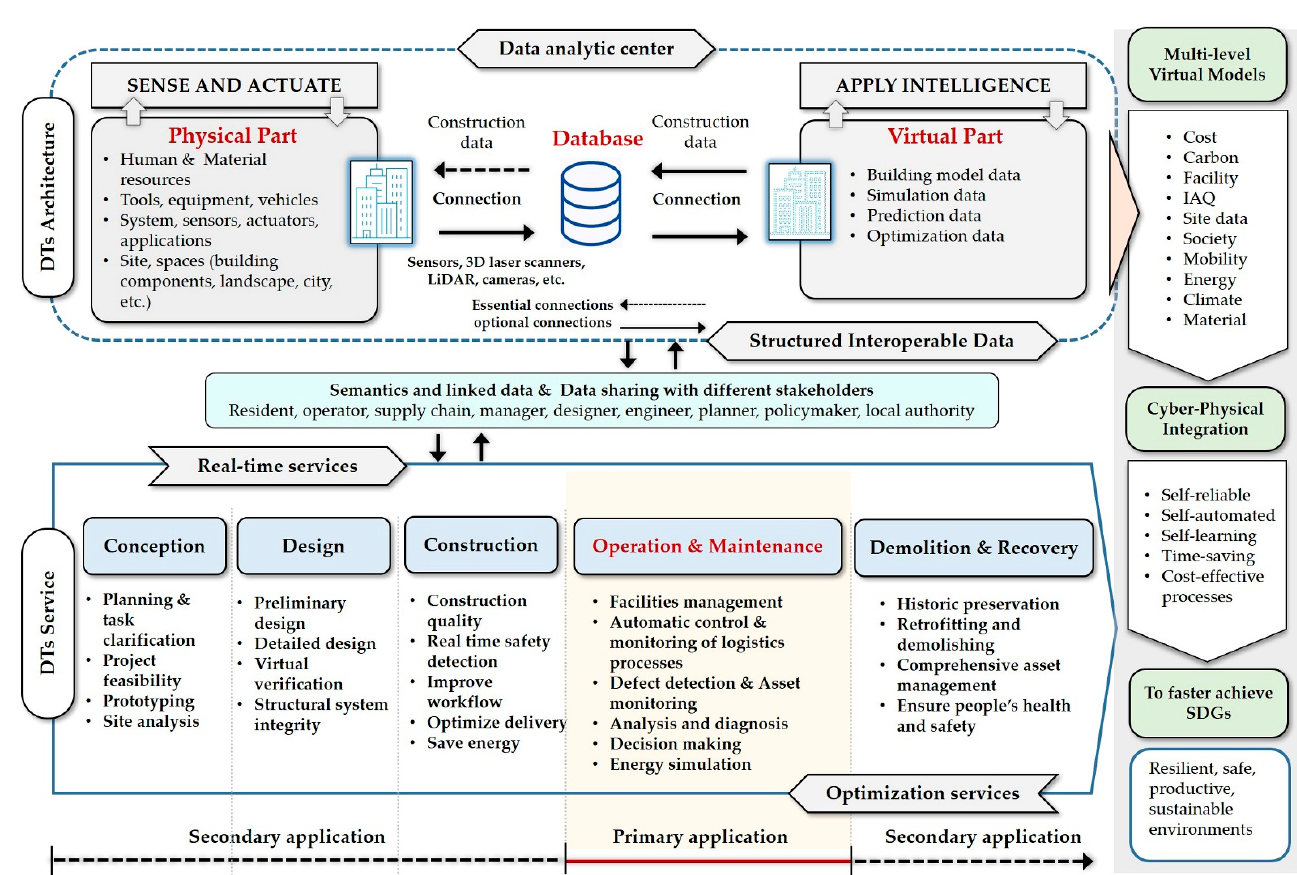
Figure 7. The AECO sector’s DTs platform framework model. Adapted from Table 3. Recent DTs-based applications in the AECO industry.